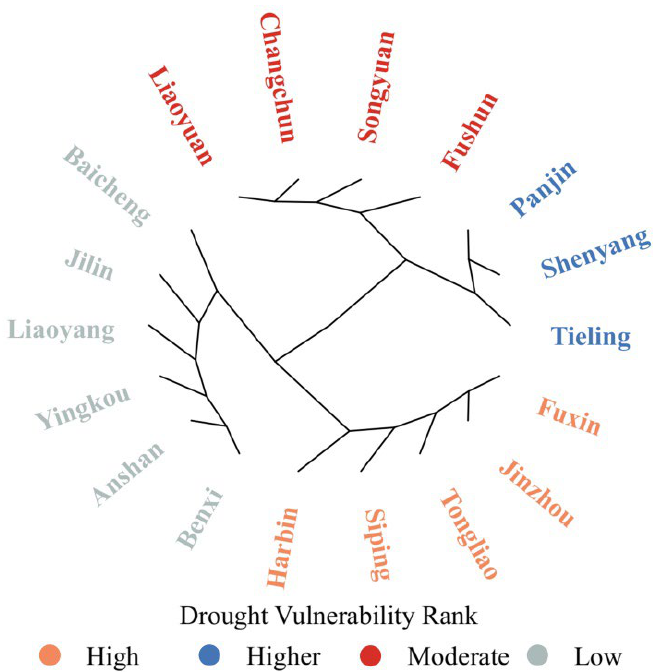
Figure 9. Classification and zoning of maize drought vulnerability in Songliao Plain.